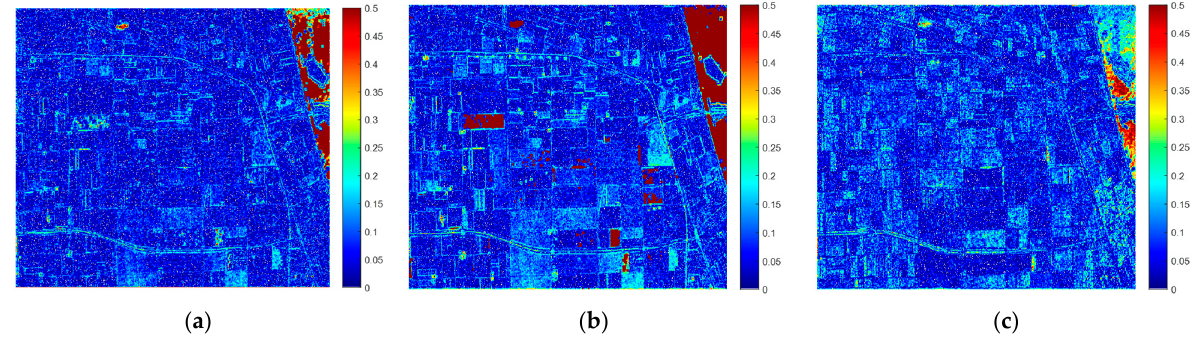
(cid:68) (cid:69) 2 2 S . ( a ) Souyris’ model. ( b ) Nord’s model. ( c ) Proposed S . ( a ) Souyris’ model. ( b ) Nord’s model. ( c ) Proposed | S HV | 2 . ( a ) Souyris’ model. ( b ) Nord’s model. ( c ) Proposed HV HV